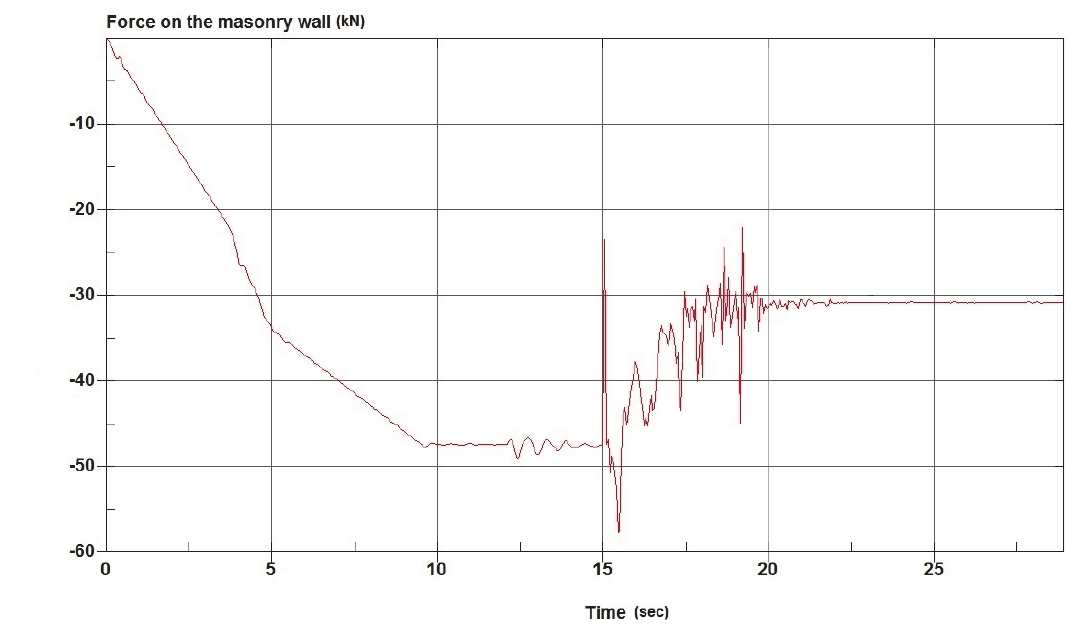
Figure 10: Force time history on the non-collapsed